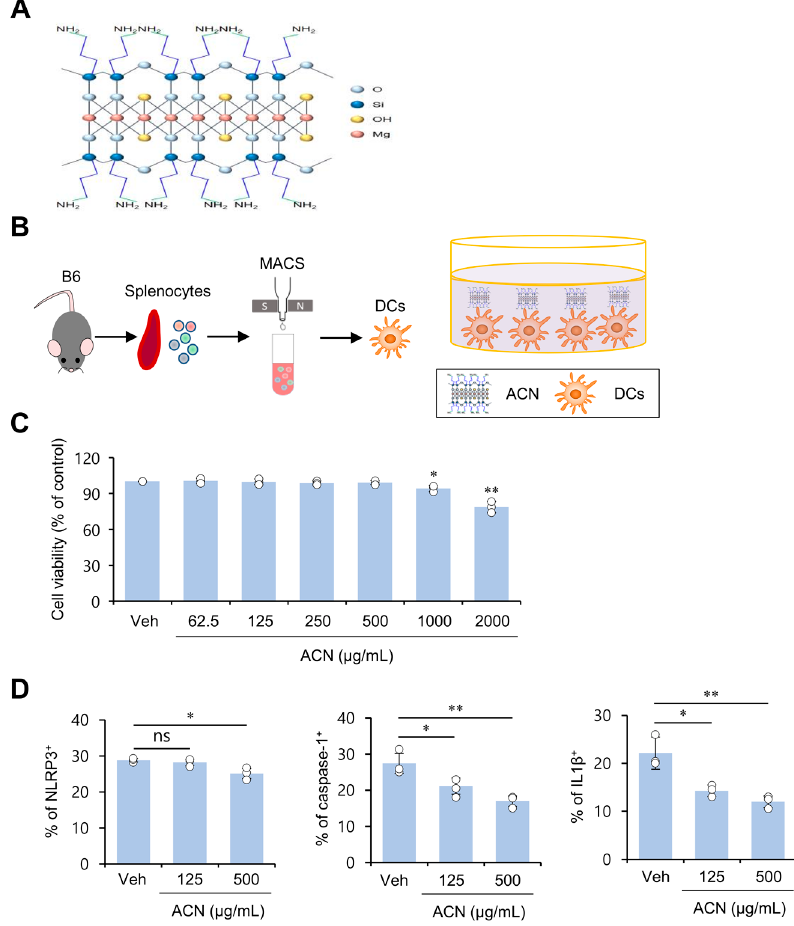
Figure 1. ACN treatment attenuates basal levels of the immunogenicity of resting DCs in vitro. ( A ) Schematic illustration for the molecular structure of ACNs. ( B , C ) Splenic CD11c + DCs were purified from B6 mice using a MACS system, and DCs were cultured with ACNs (62.5, 125, 250, 500, 1000, and 2000 μ g/mL) for 16 h. ( C ) The frequency of viable cells (annexin-V − 7AAD − ) among DCs was assessed using flow cytometric analysis. ( D ) Splenic DCs were cultured with ACNs (125 and 500 μ g/mL). 16 h later, intracellular expression of NLRP3, caspase-1, and IL1 β in DCs was assessed via flow cytometry. The mean values ± SD ( n = 3; per group in the experiment; Student’s t -test; * p < 0.05, ** p < 0.01) are shown. One representative experiment of two experiments is shown. ns, not signifi- cant.